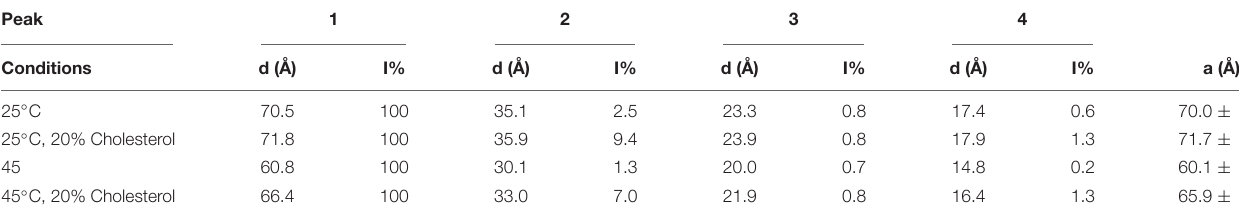
TABLE 2 | Effect of adding cholesterol (20 wt% of lipid) on the lamellar structures of 70 wt% porcine brain sphingomyelin in water containing 0.9 wt% (154 mM) NaCl and 1 mM